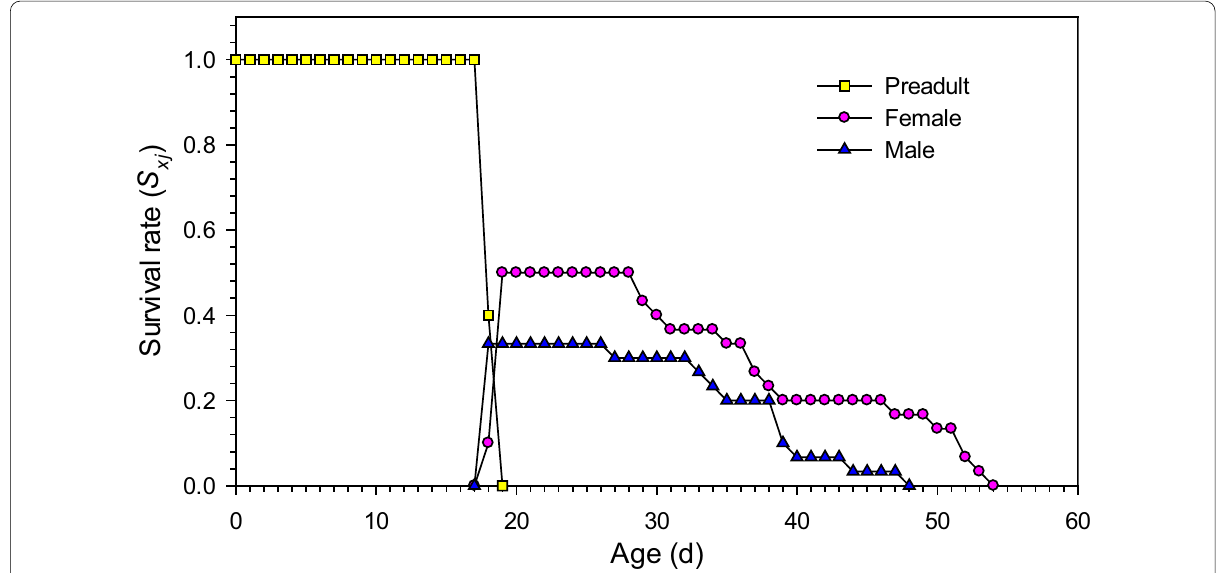
Fig. 1 Age-stage-specific survival rate ( s xj ) of Leptomastix dactylopii on Planococcus ficus